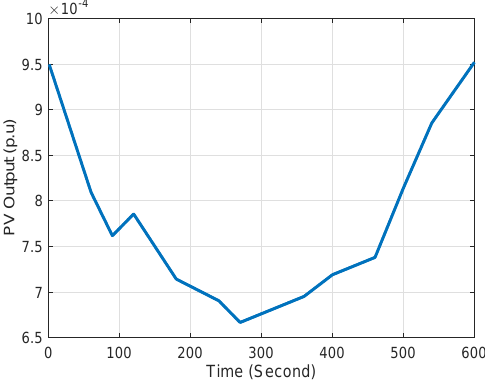
Figure 8. Profile of the predicted PV real power output with a 1-s resolution from 2:00 p.m. to 2:10 p.m.